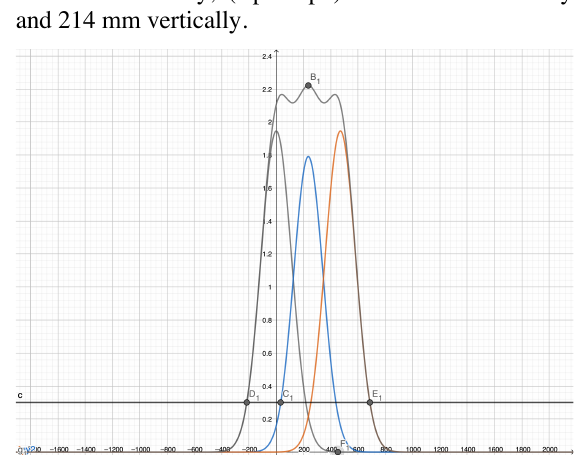
Fig. 8 . Beams (Bp1+Bp2), (Bp6+Bp7) and (Bp4+Bp5) superposed in the vertical direction